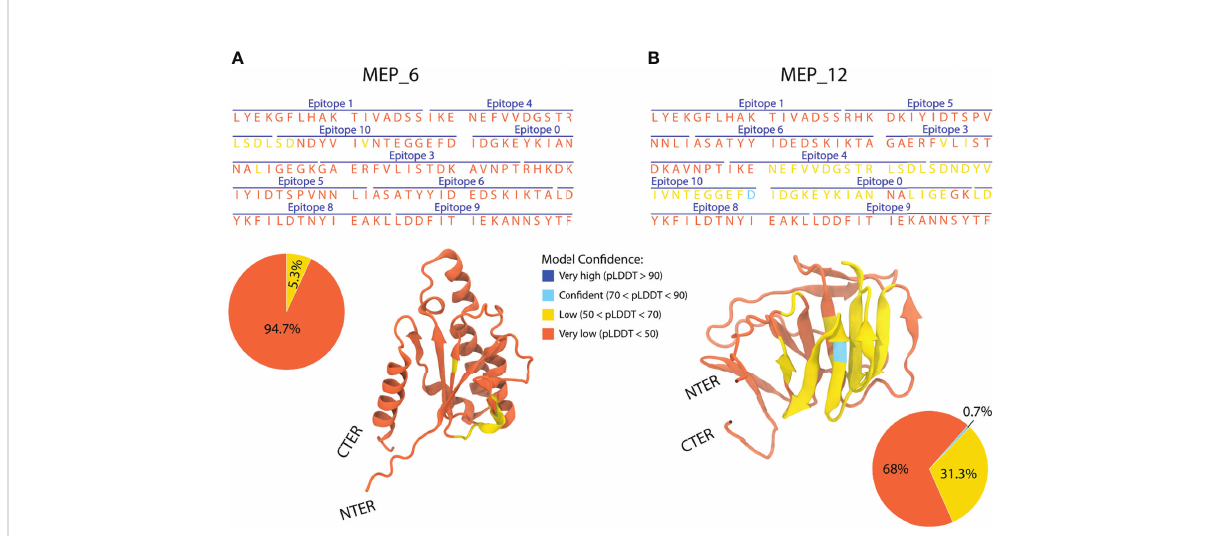
FIGURE 5 Amino acid sequence, epitope sorting and AlphaFold2 3D model of the multi-epitope constructs MEP_6 (A) and MEP_12 (B) . The con fi dence value (pLDDT) is categorized in 4 groups (orange, yellow, cyan, and blue), representing their percentage in pie